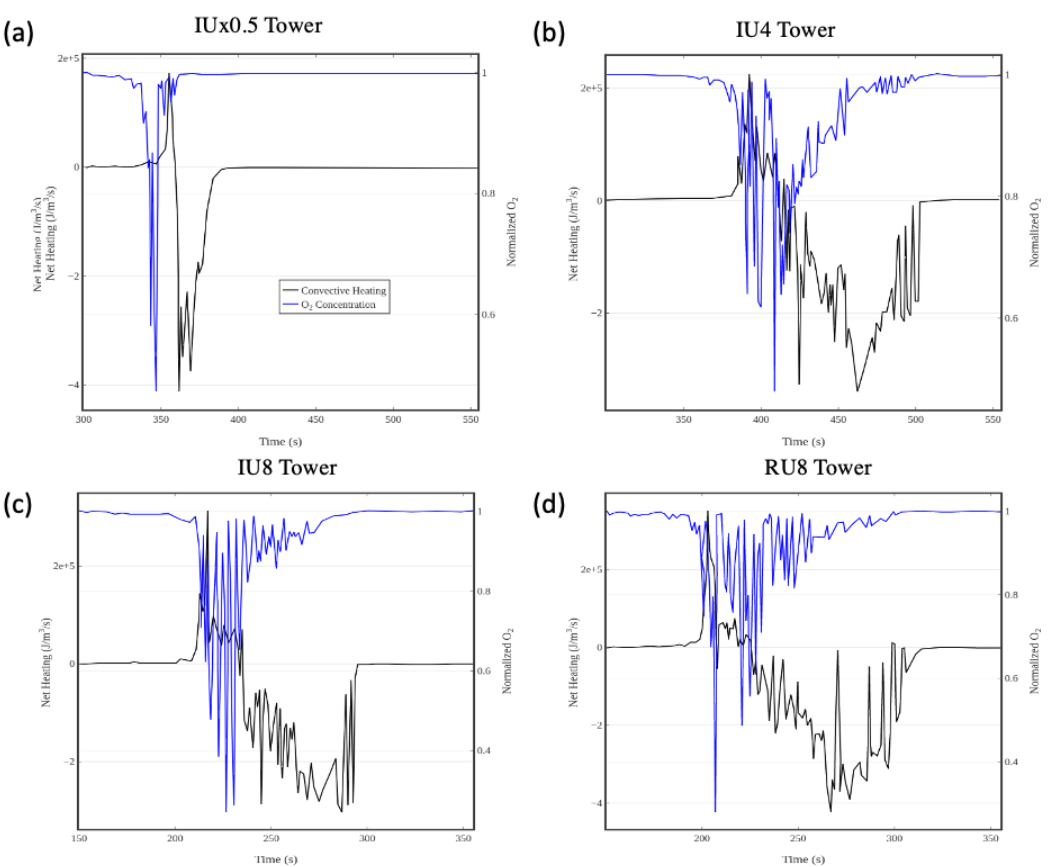
Figure 5. Non-stationary tower plots of oxygen concentration (blue lines) and convective heat flux to the fuels (black lines). Panel titles indicate the simulation cases being depicted. ( a ) IUx0.5 Tower ( b ) IU4 Tower ( c ) IU8 Tower ( d ) RU8